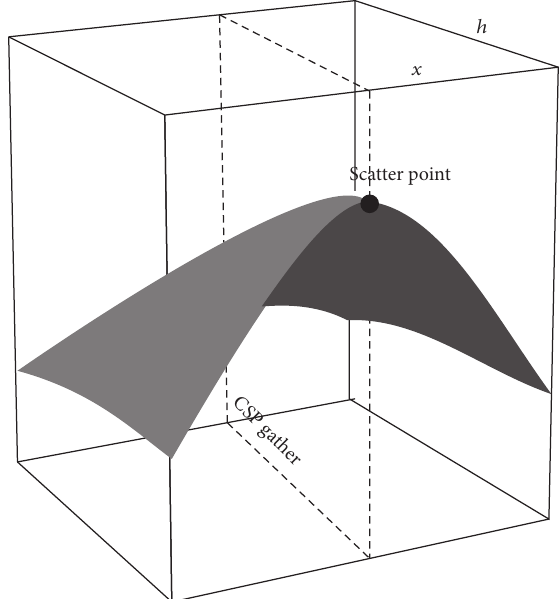
Figure 3: The sketch map to illustrate the mapping of the input data to the CSP gather. The shadowed surface is the Cheops pyramid and the dashed box is the plane where the CSP gather is